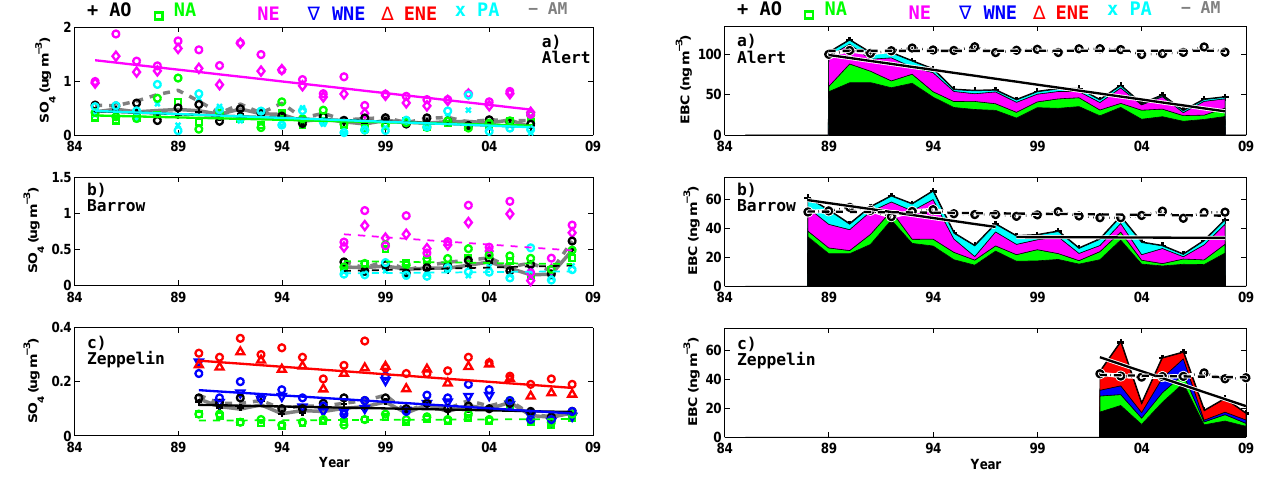
Fig. 16. The annual mean EBC concentrations measured at Alert (a) , Barrow (b) , and Zeppelin (c) and split into contributions from the four transport clusters. The solid line shows the linear trend through the measured concentrations. The circles show the annual mean EBC concentrations when the cluster-mean concentrations are held constant over time (means over the first three years). This line is influenced only by changes in the frequencies of the four clusters. The dashed line shows the linear trend of these